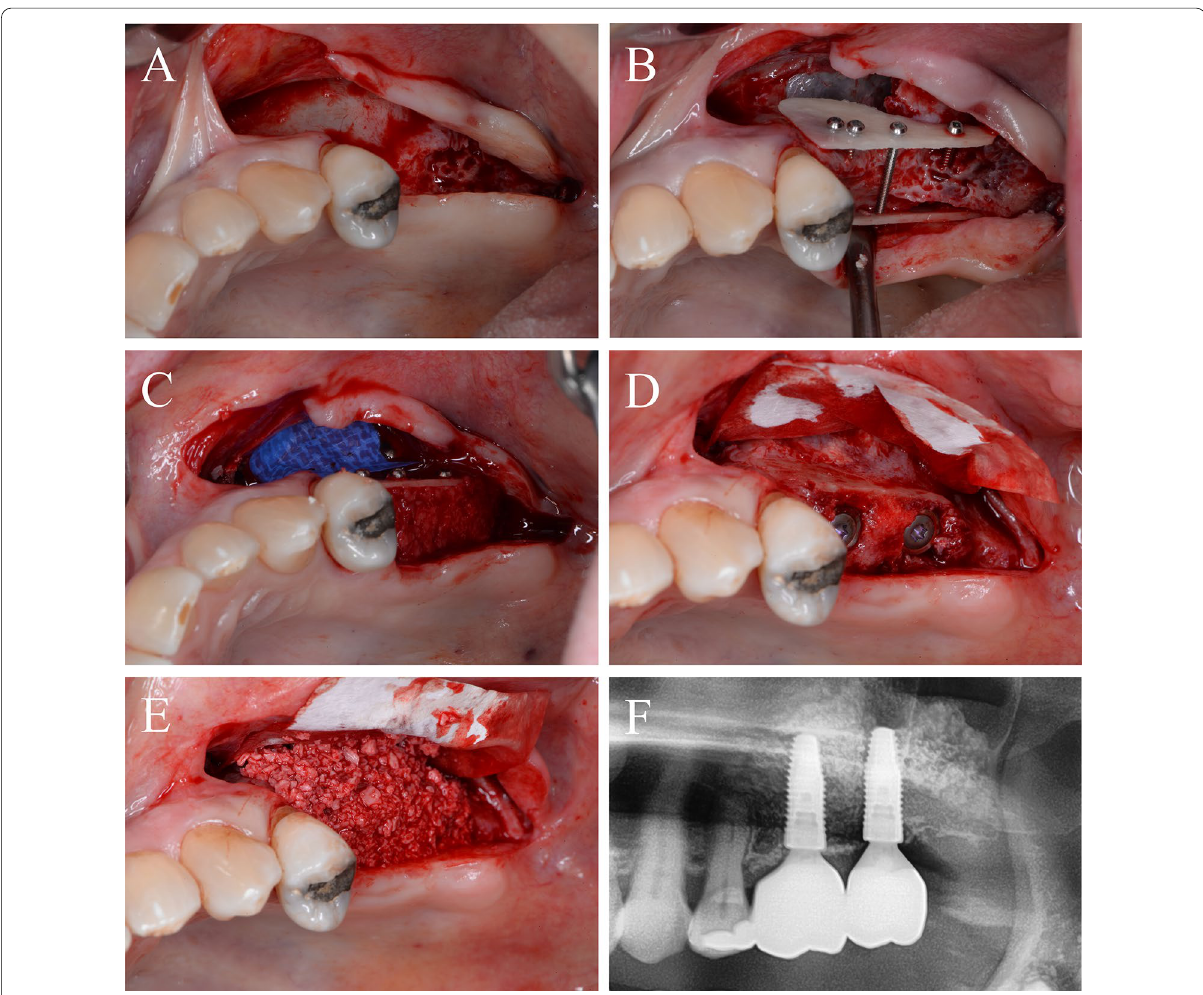
Fig. 3 Alveolar ridge augmentation of the posterior maxilla. A Initial intraoperative situation with an extended alveolar defect of the posterior alveolar jaw. B Intraoperative situation after sinus floor elevation and fixation of two allogeneic cortical bone plates buccal and palatinal using four fixation screws. C Intraoperative situation after filling sinus floor with xenogeneic bone substitute, covering it with PTFE matrix and filling the alveolar crest with allogeneic spongious granules. D After 4 months, sufficient bone remodeling, screws removed, and implants inserted. E Overlining with xenogeneic granules for resorption protection and covered by collagen matrix. F X-ray demonstrating inserted